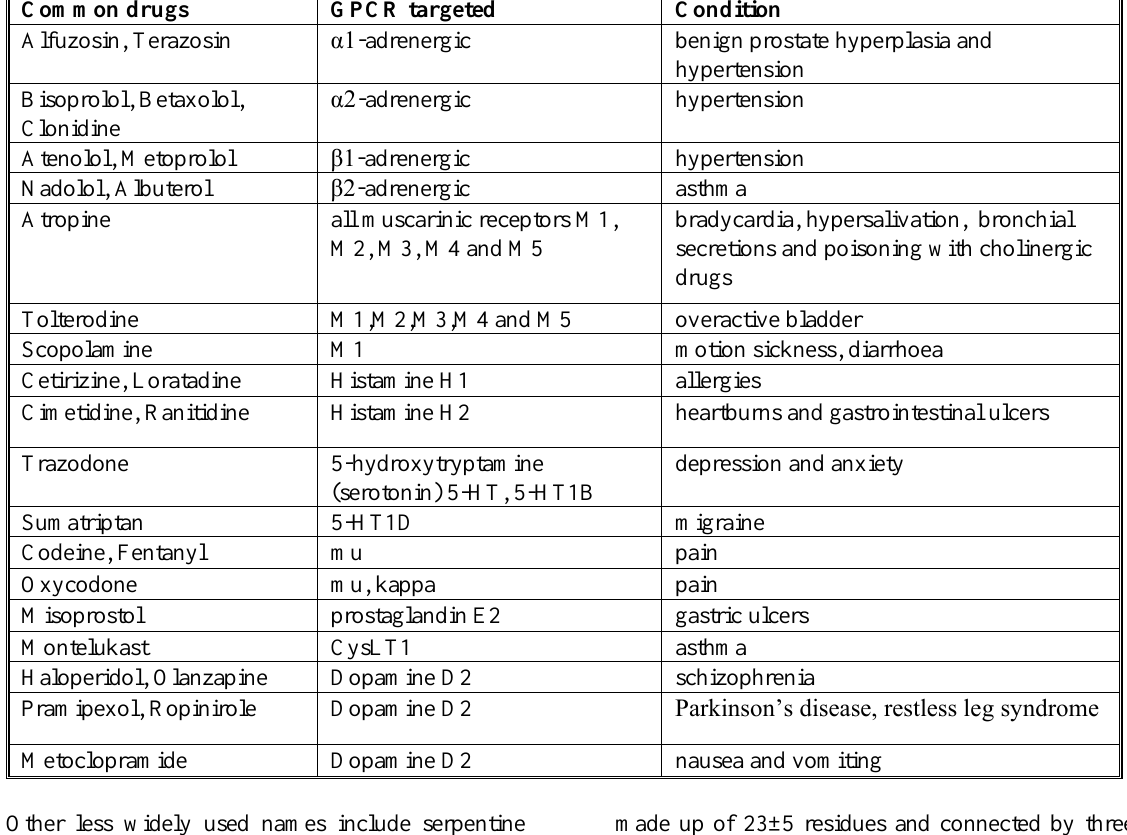
Table 1. Some common drugs targeting various G protein-coupled receptors (GPCRs) (114,115) Common drugs